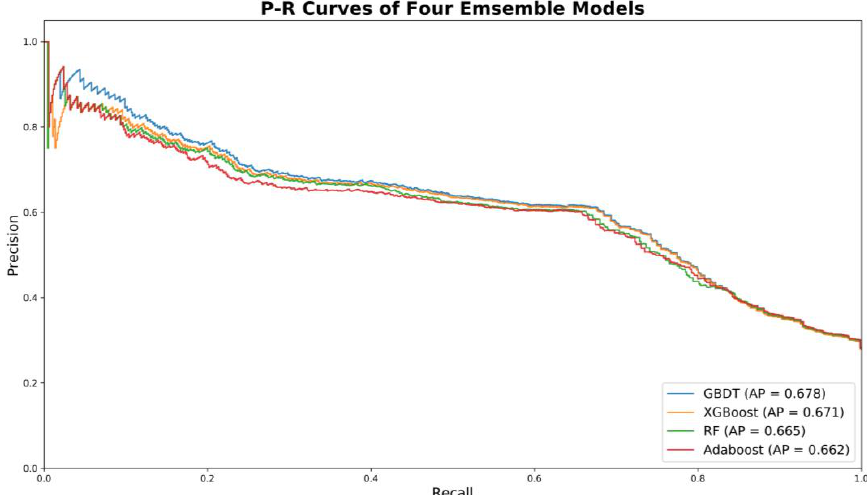
Figure 6. Precision–recall curves of four trained models for 2016–2017 Figure 6. Precision – recall curves of four trained models for 2016 – 2017 period.